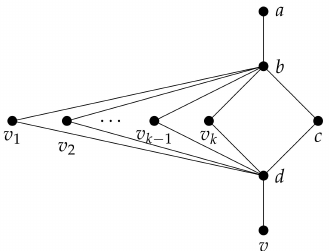
Figure 2. A graph H where V ( H ) is the γ st ( H ) -set. Since { a , b , c , d } forms a γ st ( H − { v } ) -set, we have that γ st ( H ) − γ st ( H − { v } ) = k + 1 for every integer k ≥